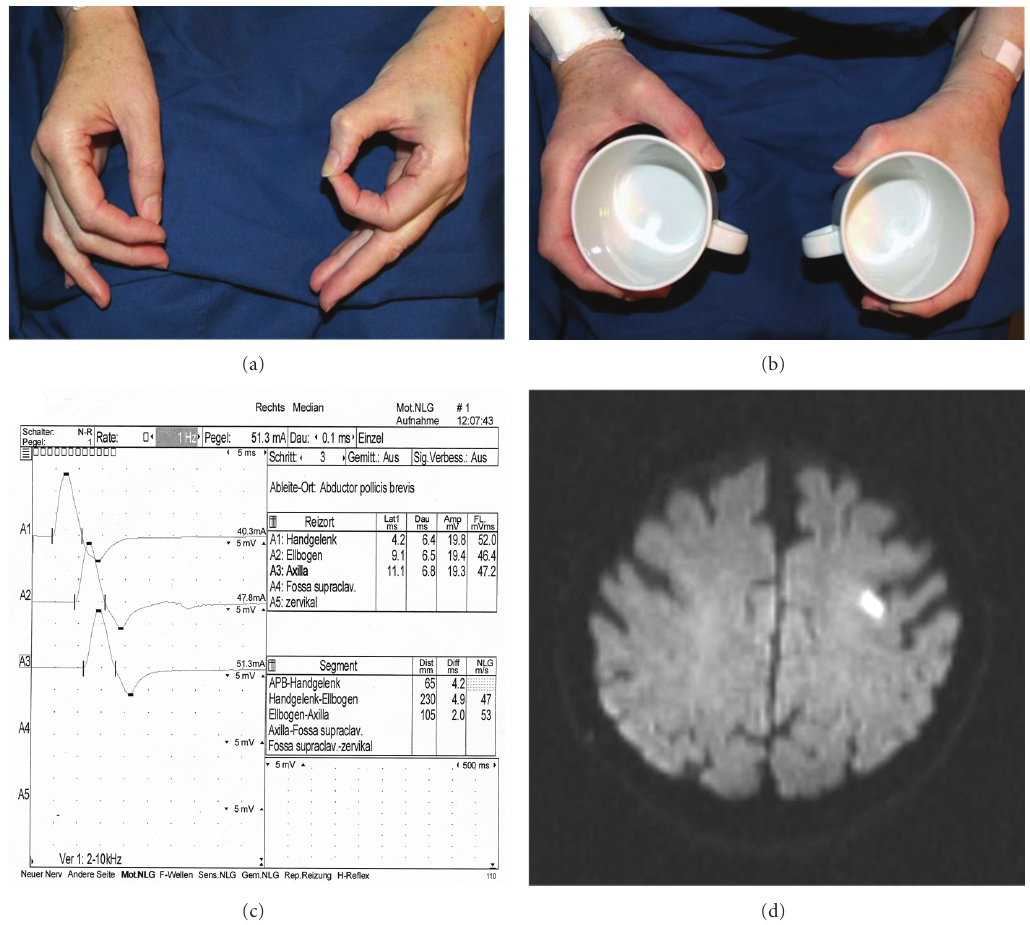
Figure 1: (a) Pathological “circle sign” of the right hand. The patient is unable to correctly oppose the tips of digits I and II due to weakness of flexor pollicis longus muscle and the flexor digitorum profundus muscle of the index finger, (b) L¨uthy’s bottle sign. See the gap between the cup and the skin web due to weakness of thumb adduction, opposition, and flexion in median nerve lesion, (c) Normal neurography of the right median nerve, (d) Di ff usion-weighted magnetic resonance imaging showing an acute infarction in the “hand knob” area of the left precentral